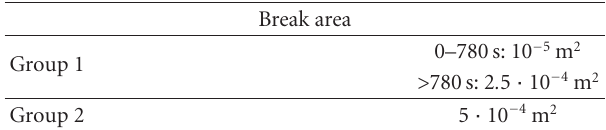
Table 1: RCP break area for the two groups of analyzed